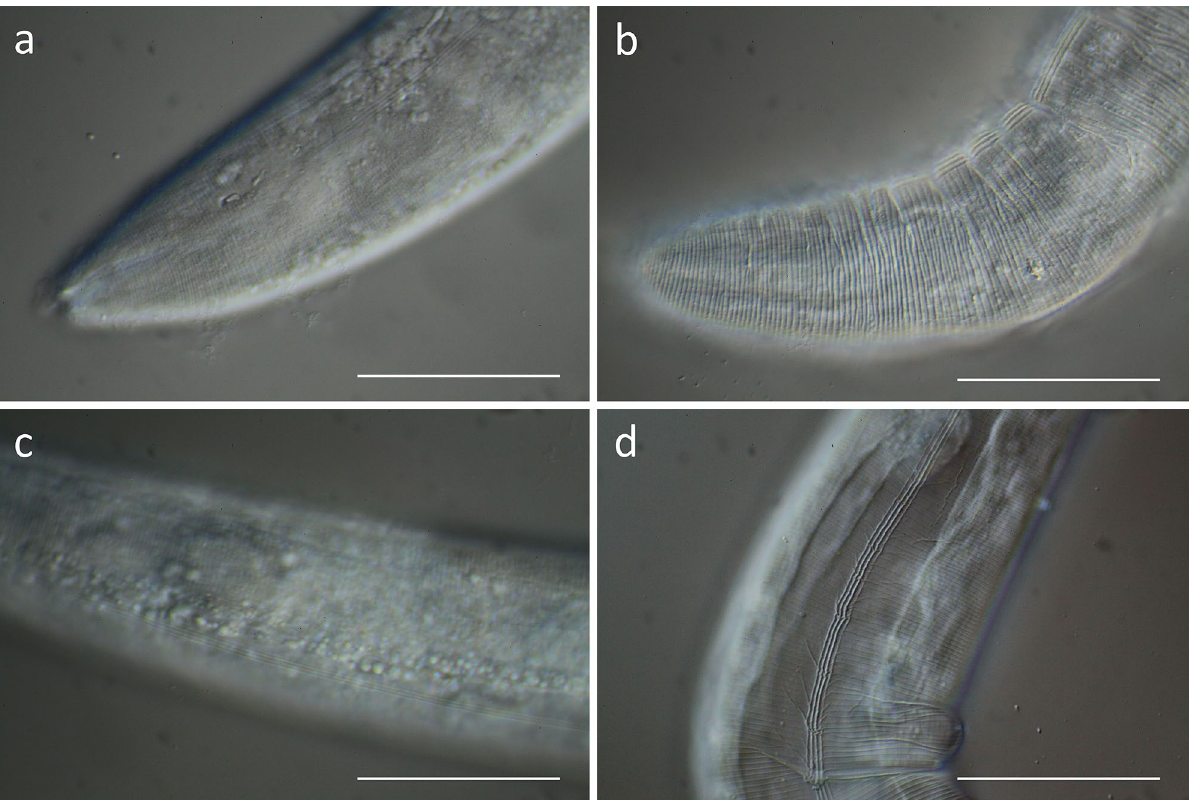
Figure 1. Differential interference contrast microscopy (DIC) of the cuticle surface of young adult C. elegans in head and mid-body region after 24 h of treatment followed by 6 h of regeneration on NGM agar. ( a , b ) Untreated control (M9 buffer with 1% DMSO), ( c , d ) worms treated with CM (2 mg/ml). Scalebar 50